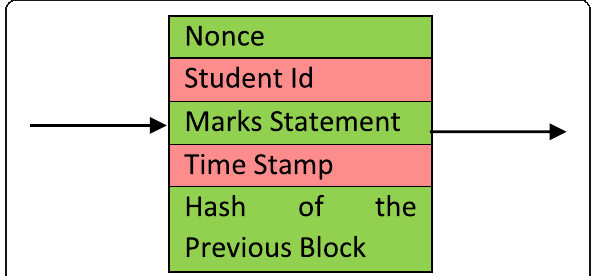
Fig. 2 The structure of the proposed